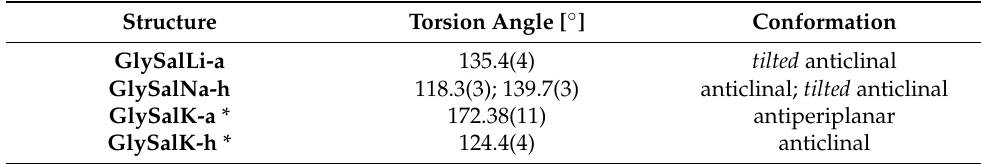
Table 2. Torsion angles along C7-N1-C8-C9 bonds for GlySalX structures, where X—selected alkali metals. Anhydrous compounds are denoted with a, while hydrated with h. Structure Torsion Angle [ ◦ ] Conformation GlySalLi-a 135.4(4) tilted anticlinal GlySalNa-h 118.3(3); 139.7(3) anticlinal; tilted anticlinal GlySalK-a * 172.38(11) antiperiplanar GlySalK-h * 124.4(4)